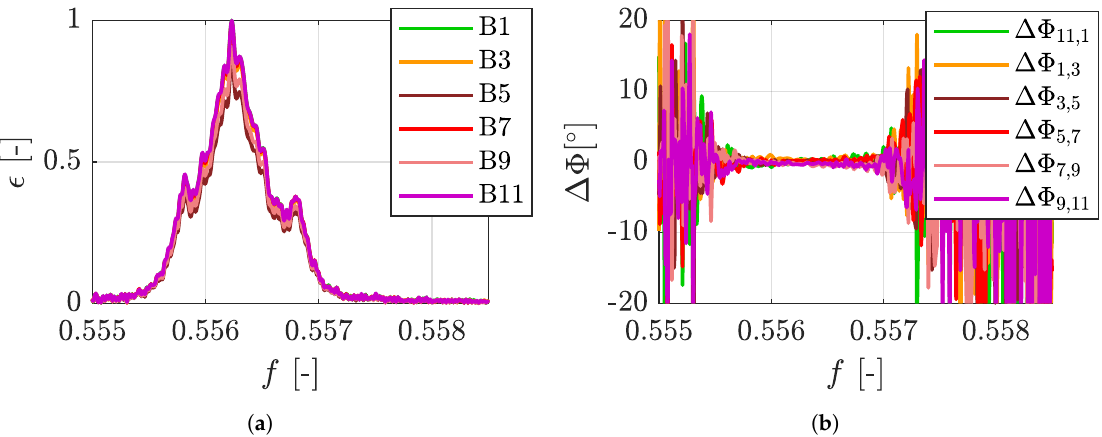
Figure 3. Vibratory Mode 5: Frequency domain and phase lag. ( a ) Normalized amplitude of all SG-applied blades during resonance M5; ( b ) Phase lag of all SG-applied blades during resonance M5 in the frequency domain.